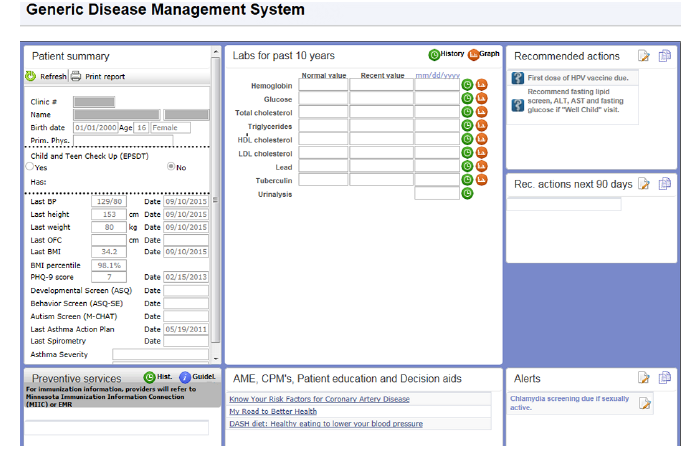
Figure 1. Decision support tool.